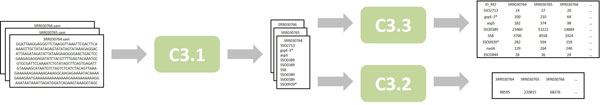
Connector C3 architecture. A rectangle represents a data source, while a rectangle with rounded corners represents a simple connector. An one-way arrow represents a directed flow of data.